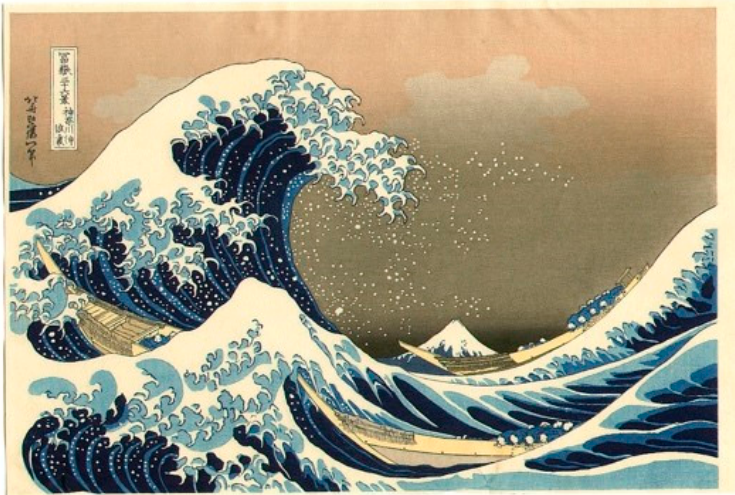
Figure 1. “Fugaku sanjurokkei Kanagawa oki namiura (the Wave off Kanagawa, from 36 Views of Mountain. Fuji” by Katsushika. (in public domain)